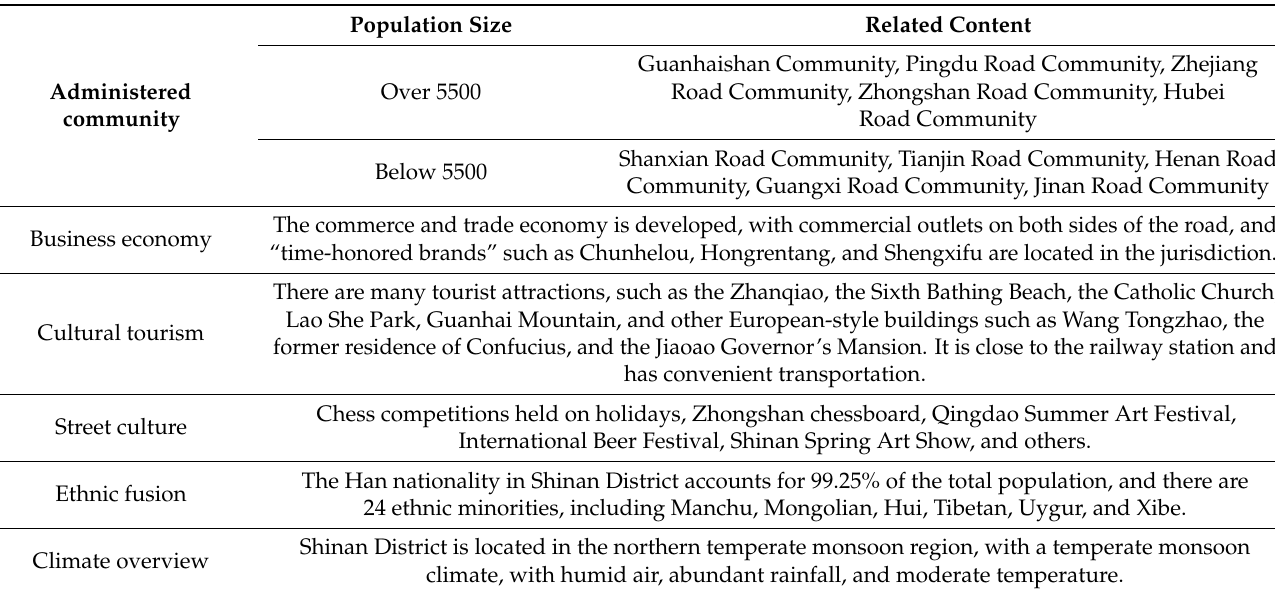
Figure 1. Location of the study area. Table 1. Overview of Zhongshan Road, Shinan District,